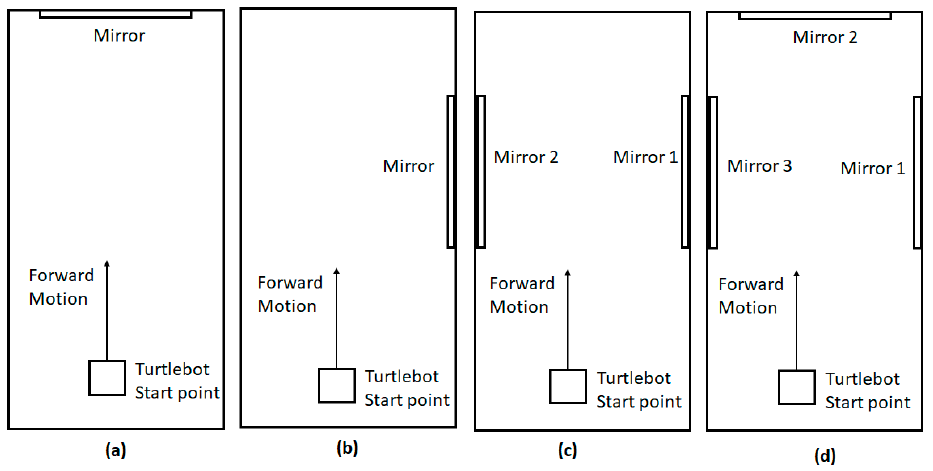
Figure 7. Schematic showing the representation of test cases 1–4 with single or multiple mirrors. ( a ) One frontal mirror. ( b ) One side mirror. ( c ) Two parallel side mirrors. ( d ) One frontal mirror and two side mirrors.